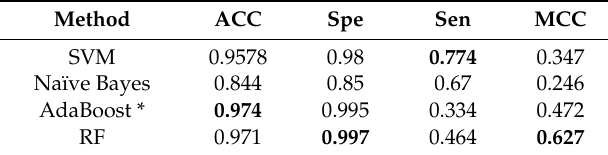
Table 2. Comparison of random forests (RF) with other classifiers.